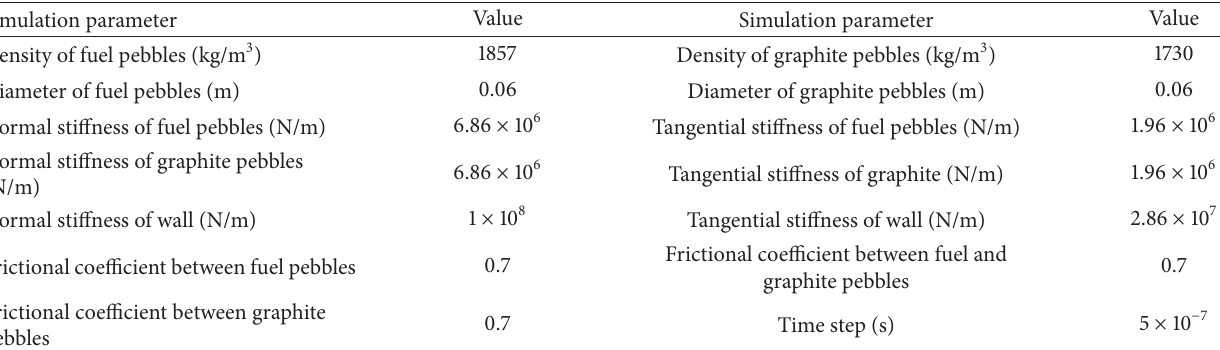
Table 1: Properties of pebbles and simulation parameters [5,